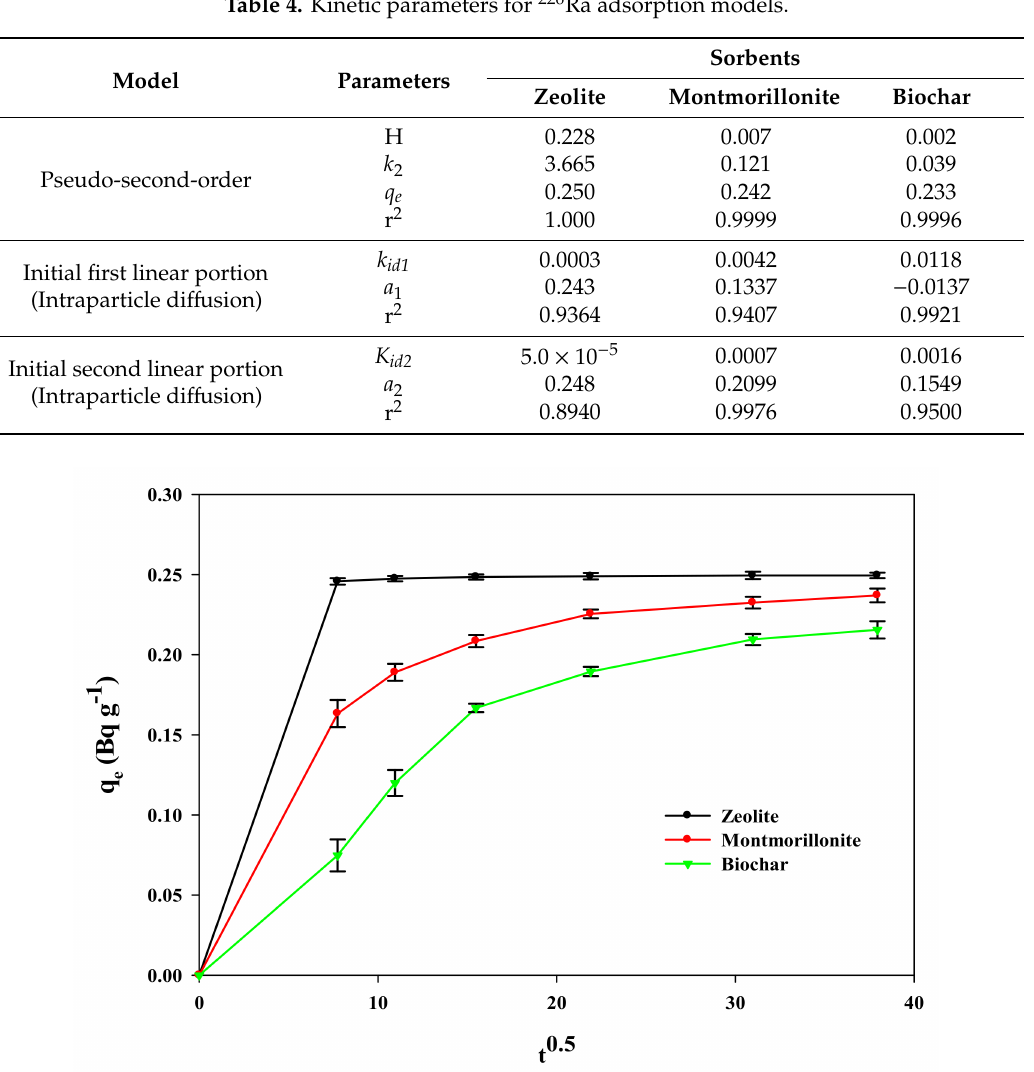
Figure 3. The 226 Ra adsorption onto the three investigated sorbents based on the intraparticle di ff usion kinetic